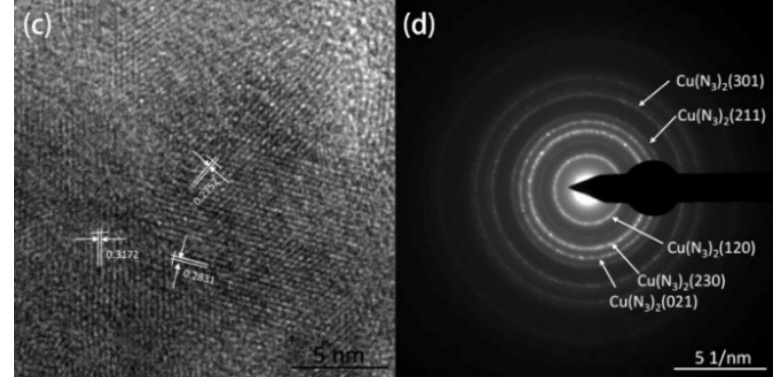
Figure 13. ( a ) HRTEM and ( b ) selective electron diffraction (SAED) images of the azide product of the Cu 2 O@CNTs film; ( c ) HRTEM and ( d ) SAED images of the azide product of the Cu@CNTs film .